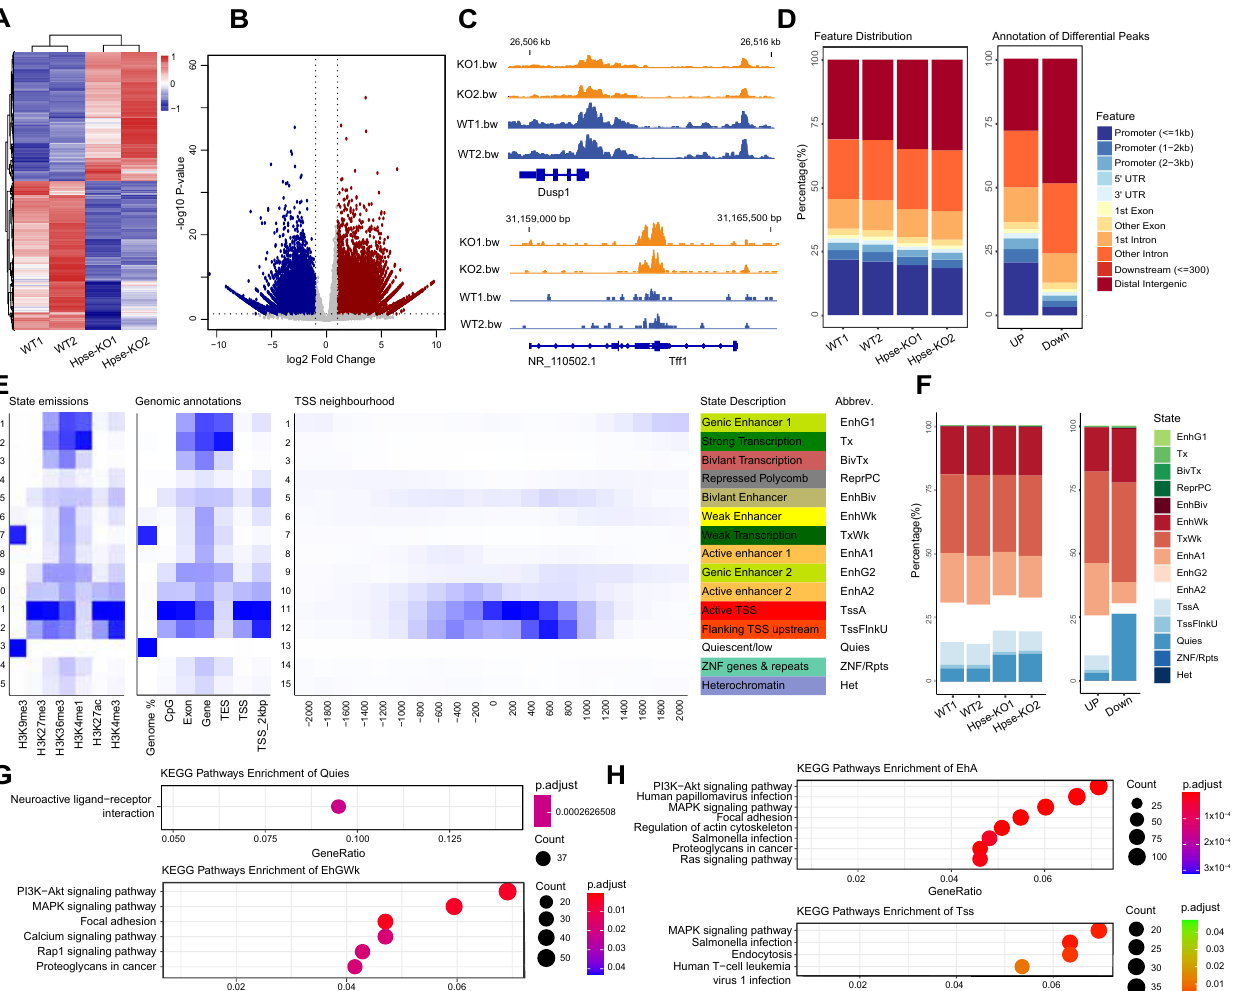
Figure 2. Identification and characterization of differential peaks. ( A ) Heatmap of normalized peak counts. ( B ) Volcano plots of differential peaks identified; downregulated peaks are indicated in blue and upregulated peaks are indicated in red. ( C ) Representative genome browser tracks of differential peaks in Dusp1 and Tff1 regions. ( D ) Genomic feature distribution of ATAC-seq peaks. ( E ) ChromHMM defined chromatin states with six histone markers. ( F ) Bar graphs, obtained based on the chromHMM results, showing the chromatin states distribution of ATAC-seq peaks. ( G ) Kyoto Encyclopedia Genome (KEGG) analysis showing significantly upregulated regions (Quies and EhGWk) in Hpse-KO samples. ( H ) KEGG analysis showing significantly downregulated regions (EnhA and TSS) in Hpse-KO